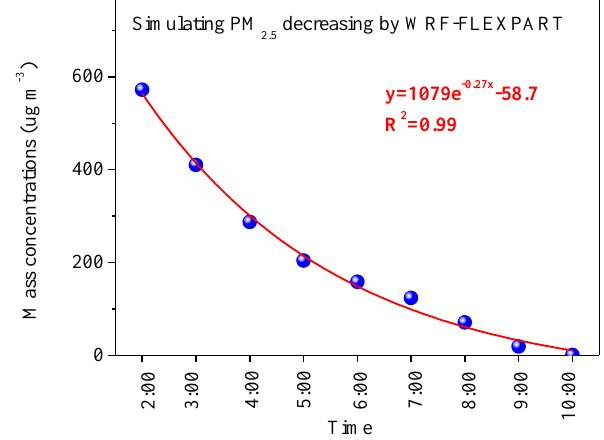
Figure 5. Particles decreasing trend on Chinese New Year’s Eve by WRF-FLEXPART simulating. The particle concentrations de- creased to 0.76µgm − 3 after 9h, faster than the real decrease as Fig. 4 shows. It can be explained as that we did not consider the injections of particles during simulating course, which biases the